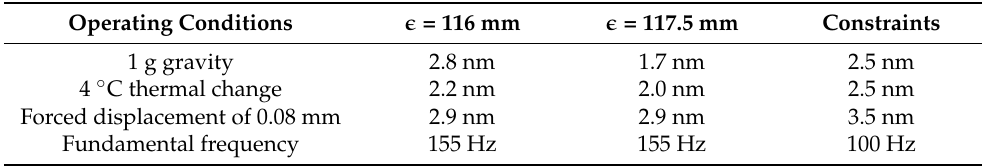
Table 4. The performance and constraints of the reconstructed mirror assembly under different load cases.